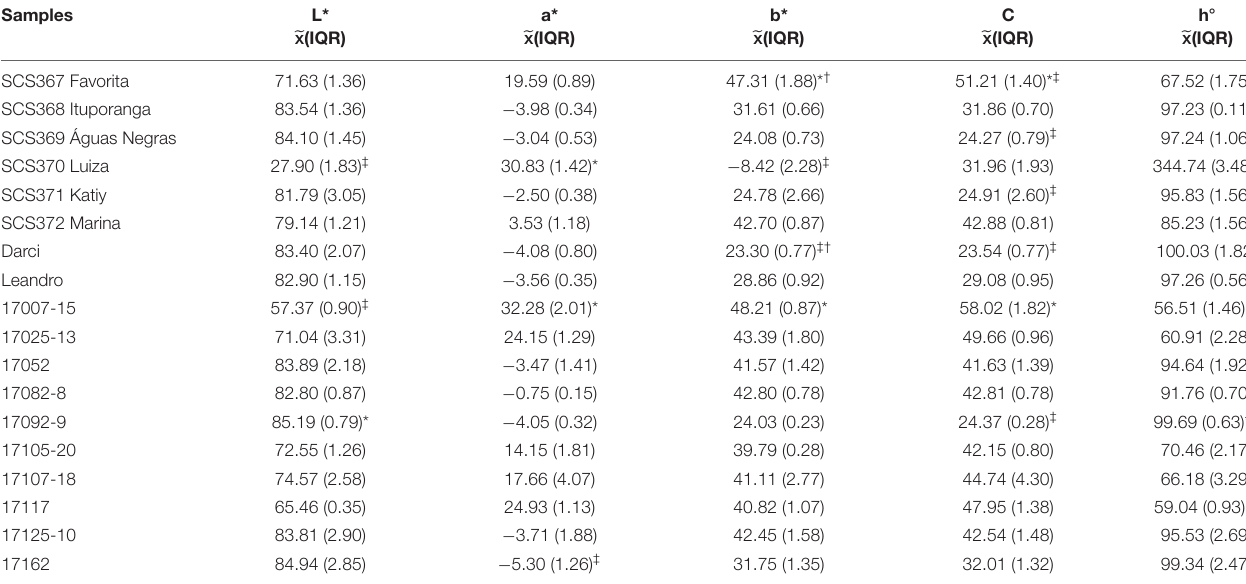
TABLE 3 | Instrumental pulp color of registered and new varieties of sweet potato cultivars.